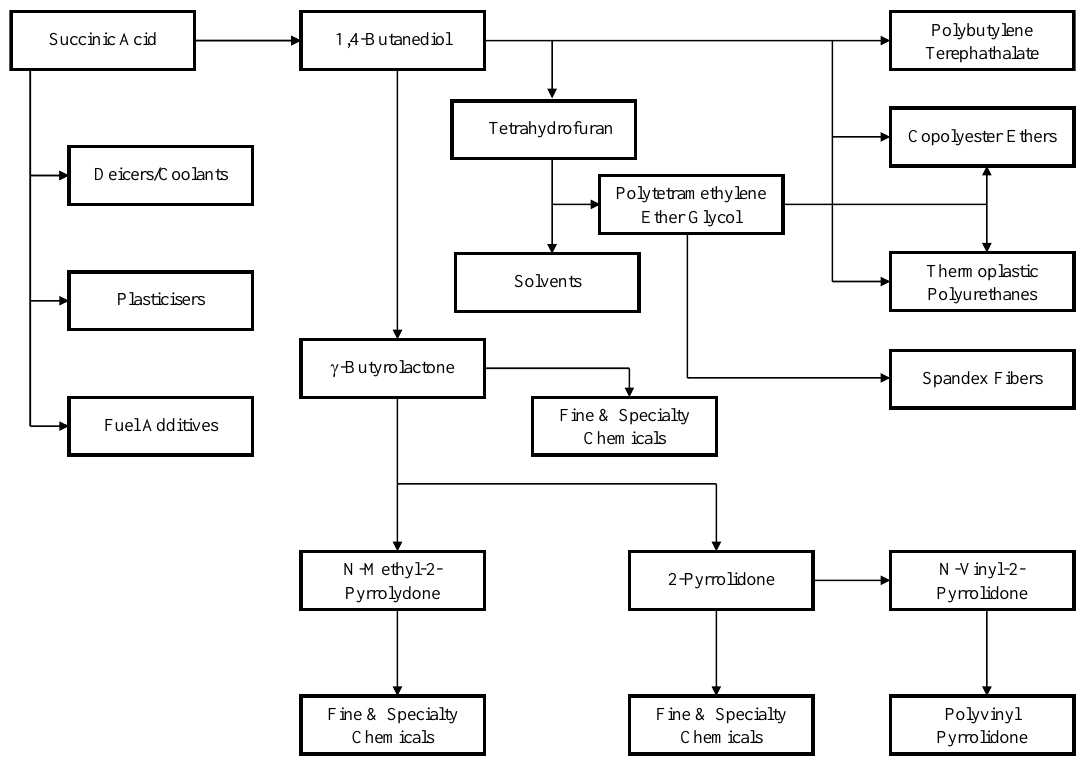
Figure 2. The potential succinic acid value chain [45]. Table 1. Projected market volume and market share for succinic acid applications for 2020 [46].